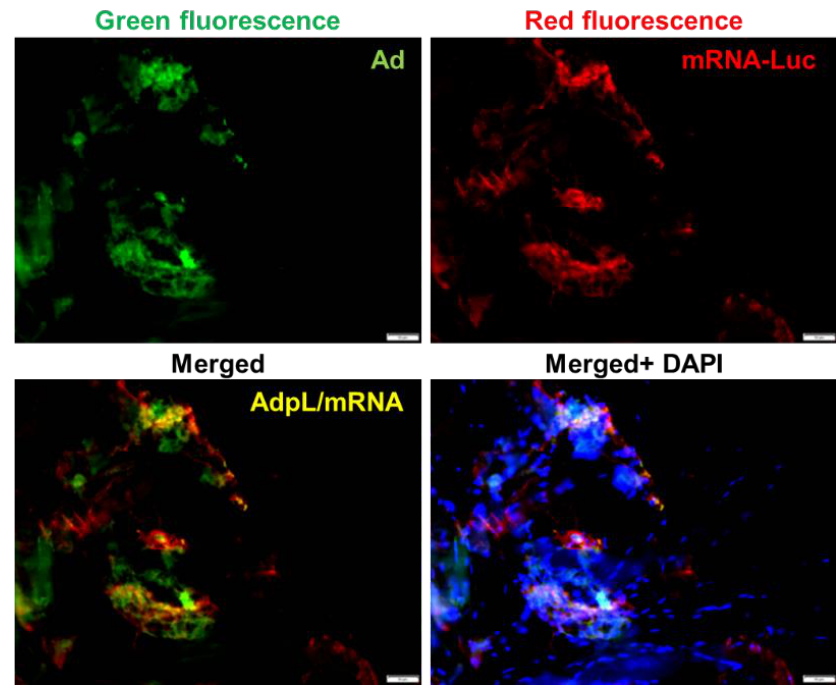
Figure 5. In vivo gene delivery via AdpL-mRNA. AdPK4-STAVpLys-mRNA complexes were administrated via intramuscular (i.m) injection to mice and immunohistochemical staining (IHC) analysis was performed from muscle tissue to evaluate in vivo gene transfer. Gene expression was verified and analyzed by co-localization signals using fluorescence microscopy. Indicated signals are as follows: Green fluorescence: reporter gene via adenoviral vector (AdPK4.CMV.GFP), Red fluorescence: firefly luciferase gene expressed by mRNA delivery using anti-firefly luciferase antibody capture, co-localization represented by yellow in merged. The fluorescence images were taken using epifluorescence microscopy (Olympus America, Center Valley, PA, USA).